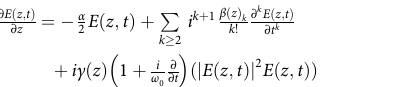
Methods Numerical simulation . The evolution of the near-VIS pulse in chirp-modulated taper AlN waveguides is numerically investigated using the generalized nonlinear